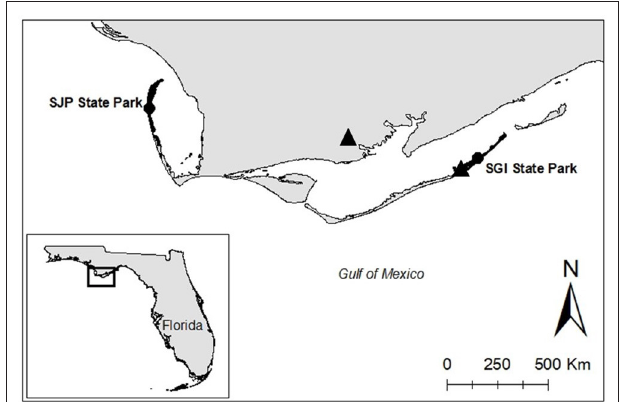
FIGURE 1 | Study sites (west to east): T.H. Stone Memorial St. Joseph Peninsula (SJP) State Park and St. George Island (SGI) State Park are shaded black and are indicated with a black circle. Triangles represent weather stations used for this study.